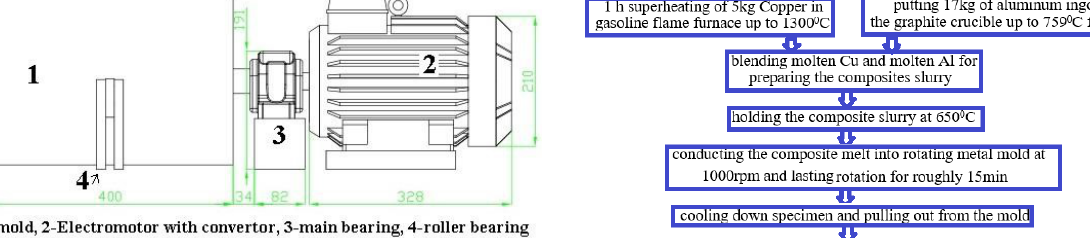
Figure 2: Schematic diagram of fabrication procedure The whole process steps are summarized in Fig.